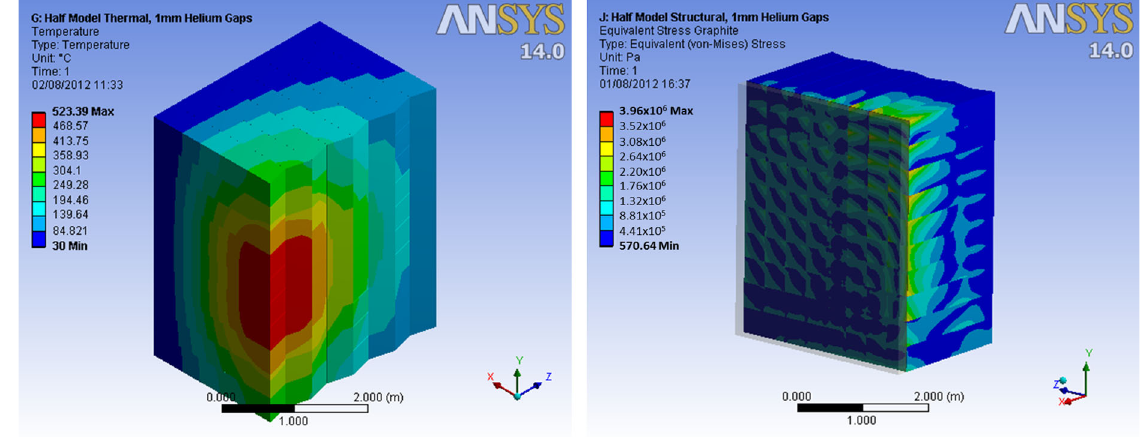
FIG. 15. Temperature (left) and von Mises stress (right) for the beam